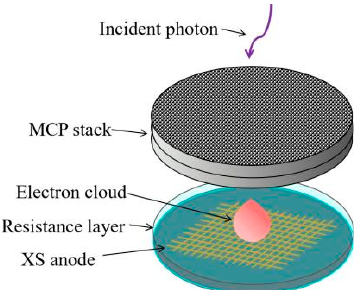
Figure 1. Schematic diagram of XS detector operation.